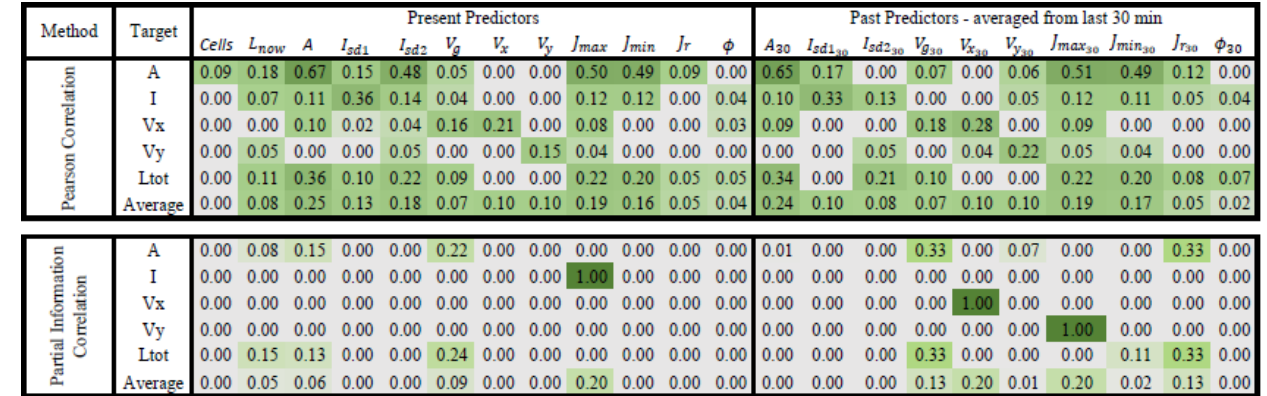
Table 3. Strength of the relationship between the selected predictors and the target variables averaged for three lead times and storm duration groups (original weights can be seen in Appendices 11.1 and 11.2) based on two predictor identification methods: upper – correlation – and lower – PIC weights. The green shade indicates the strength of the relationship, with 0 for no relationship at all and 1 for the highest